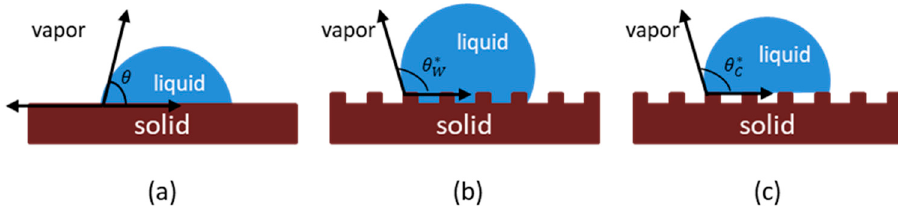
Figure 4. Schematic illustration of the Young ( a ), Wenzel ( b ), and Cassie–Baxter ( c )